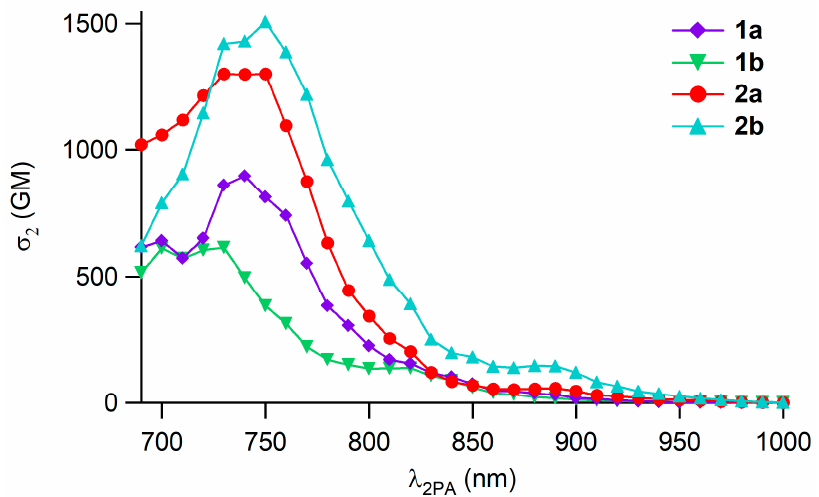
Figure 2. Two-photon absorption spectra of 1a , b and 2a , b in toluene.